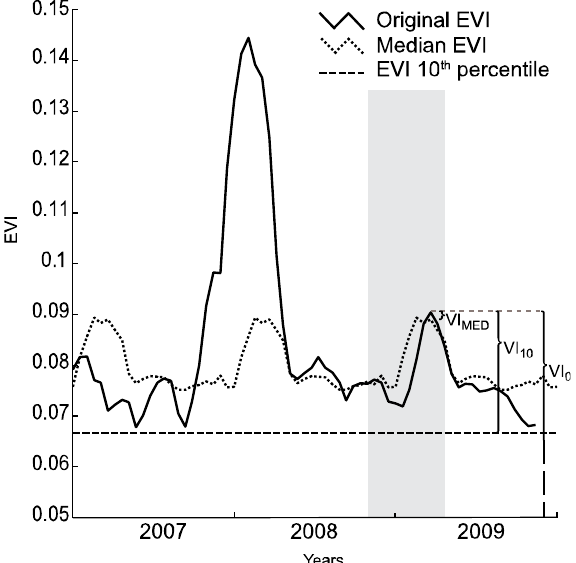
Figure 2. A portion of the smoothed EVI time-series (2007–2008) is shown to illustrate the three methods investigated for the determination of peak winter annual production in the winter of 2008–2009 for a single pixel. All three methods identify the peak of the VI in the 2008–2009 winter season (grayed area) and subtract it from a base value, as shown by the the base value is 0, making the VI labeled brackets for each of the tree techniques. For VI 0 0 the baseline is the tenth percentile for the entire value equal to the smoothed EVI. For VI 10 measure period of record from 2000 to 2009, shown as a straight dashed line, the VI 10 therefore being equal to the difference between the smoothed EVI and the value of the the baseline is tenth percentile for that pixel over the period of record. For VI MED represented by the repeating dotted line, and is the calculated as the median value for each calculated as the difference between the current period period across all years, and VI MED and the median of the period for all